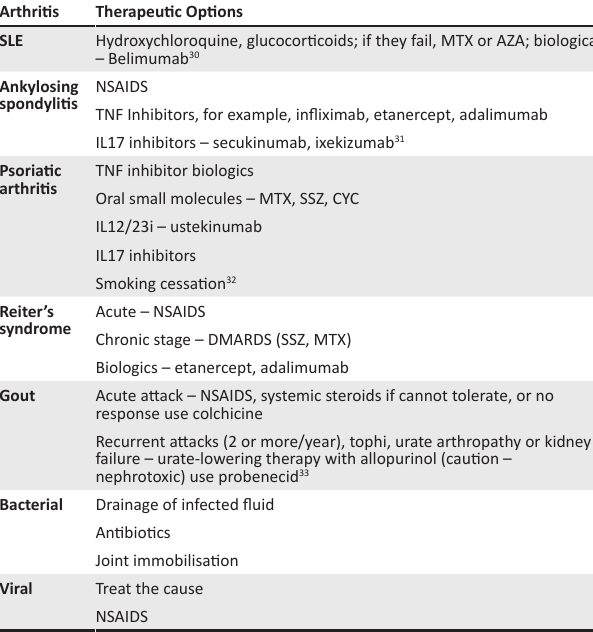
TABLE 3: Management of other